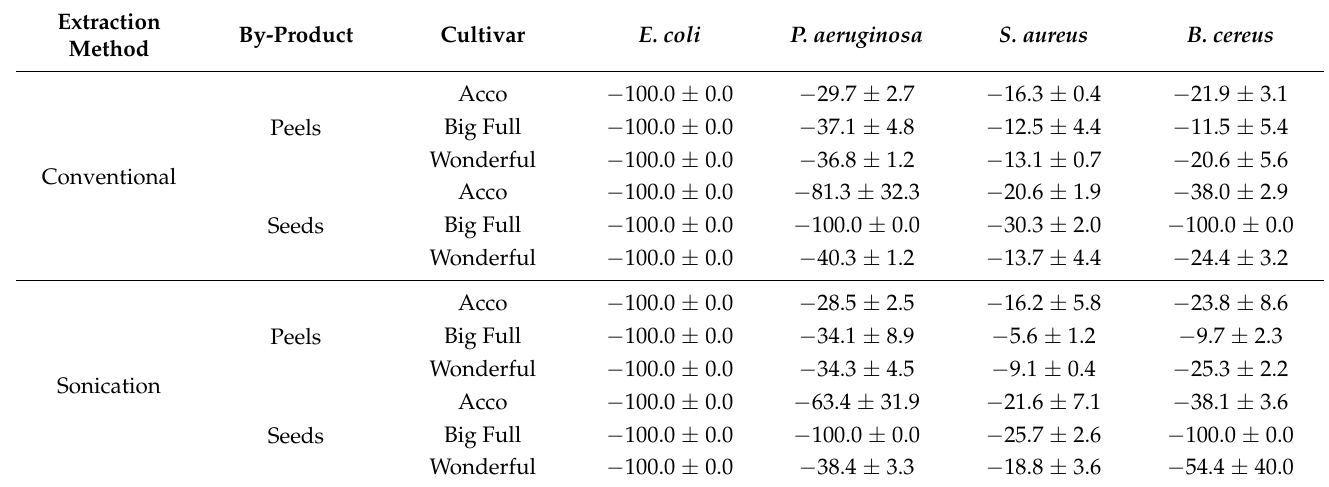
Table 6. Antimicrobial activity index (%) for peels and seeds extracts of Acco, Big Full, and Wonderful cultivars, from both extractions, relative to